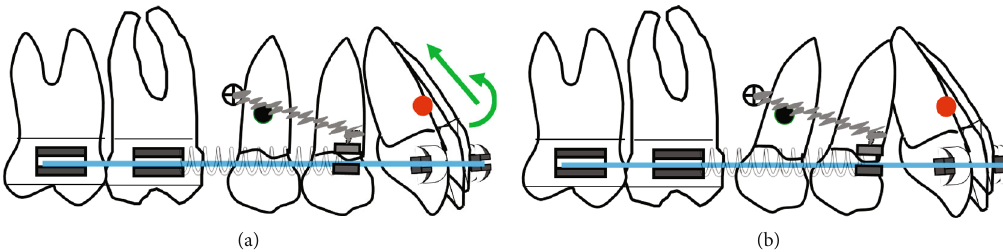
Figure 3: (a) When the open coil is extended, simultaneous distalization of the fi rst and second molar will result and since it is a rigid system with indirect mechanics represented by the steel ligature, the whole system will rotate around a fi xed point represented by the microimplant introducing maxillary incisor intrusion and counterclockwise rotation of the maxillary arch (green arrows). (b) Spontaneous distal drifting of premolars will follow.